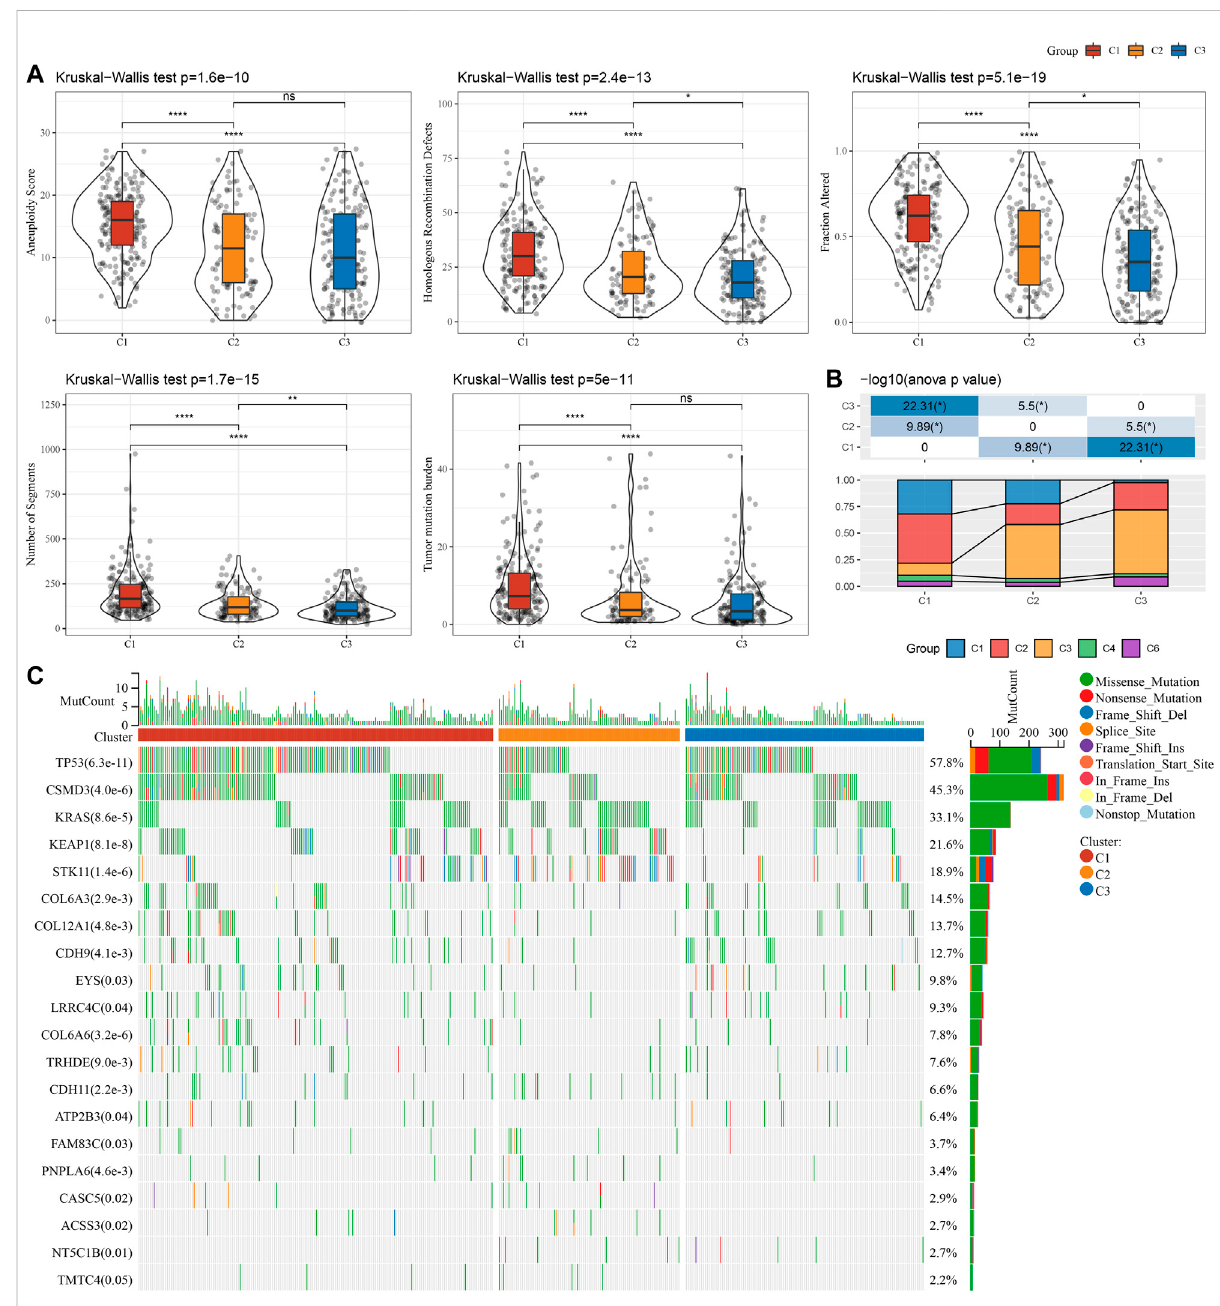
FIGURE 3 Genomic changes of molecular subtypes in TCGA cohort. (A) The differences in Homologous Recombination Defects, Aneuploidy Score, Fraction Altered, Number of Segments, and Tumor mutation burden among the molecular subtypes of TCGA cohort were compared; (B) Comparisonofthreemolecularsubtypesandimmunemolecularsubtypes; (C) Somaticmutationsinthreemolecularsubtypes(chi-squaretest).* p < 0.05, ** p < 0.01, *** p < 0.001, and **** p <